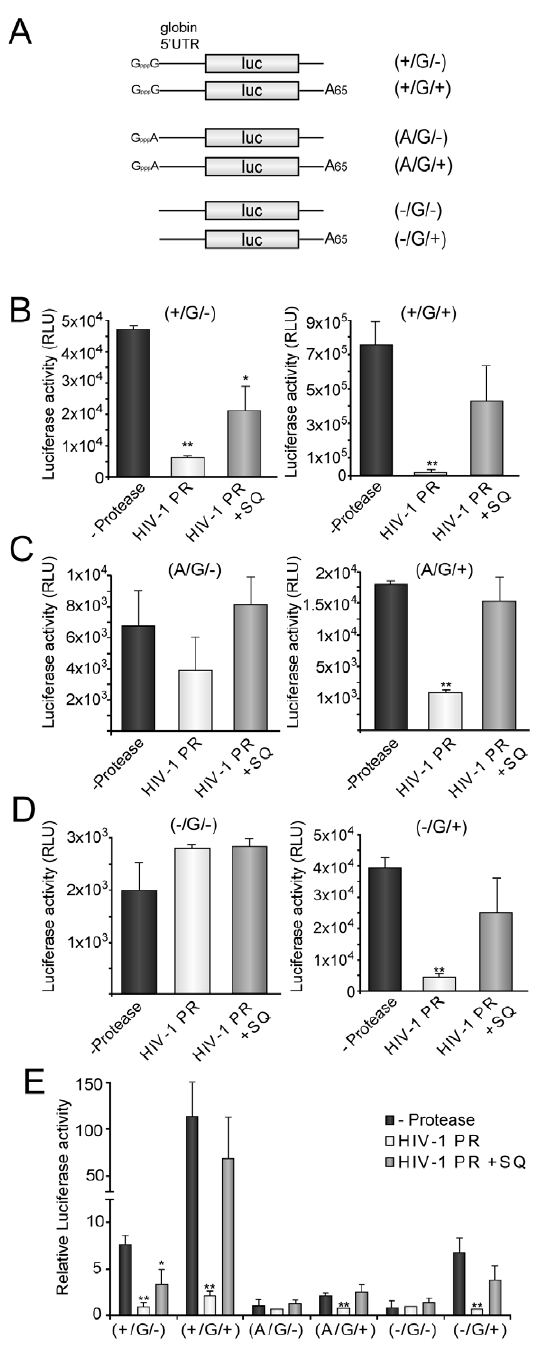
Figure 2. Analysis of cap- and poly(A)-dependent translation of luc mRNAs in HIV-1 PR treated HeLa extracts. HeLa extracts were treated with 20 ng HIV-1 PR. After 30 min, SQ 2.5 m M was added to the lysate. Simultaneously, extracts were programmed with 20 ng ( + /G 2 ), ( + /G/ + ), (A/G/ 2 ), (A/G/ + ), ( 2 /G/ 2 ) or ( 2 /G/ + ) luc mRNAs, which are schematized in panel (A). As a control, a replicate was incubated with 2.5 m M SQ from the beginning of the reaction (grey bars). B, C and D) Luc activity was analyzed 30 min later and the data obtained from translation of each mRNA were plotted. E) Relative Luc activity obtained from each mRNA in presence and absence of HIV-1 PR was represented. S.D. were obtained from three independent experiments. *P , 0.05; **P ,